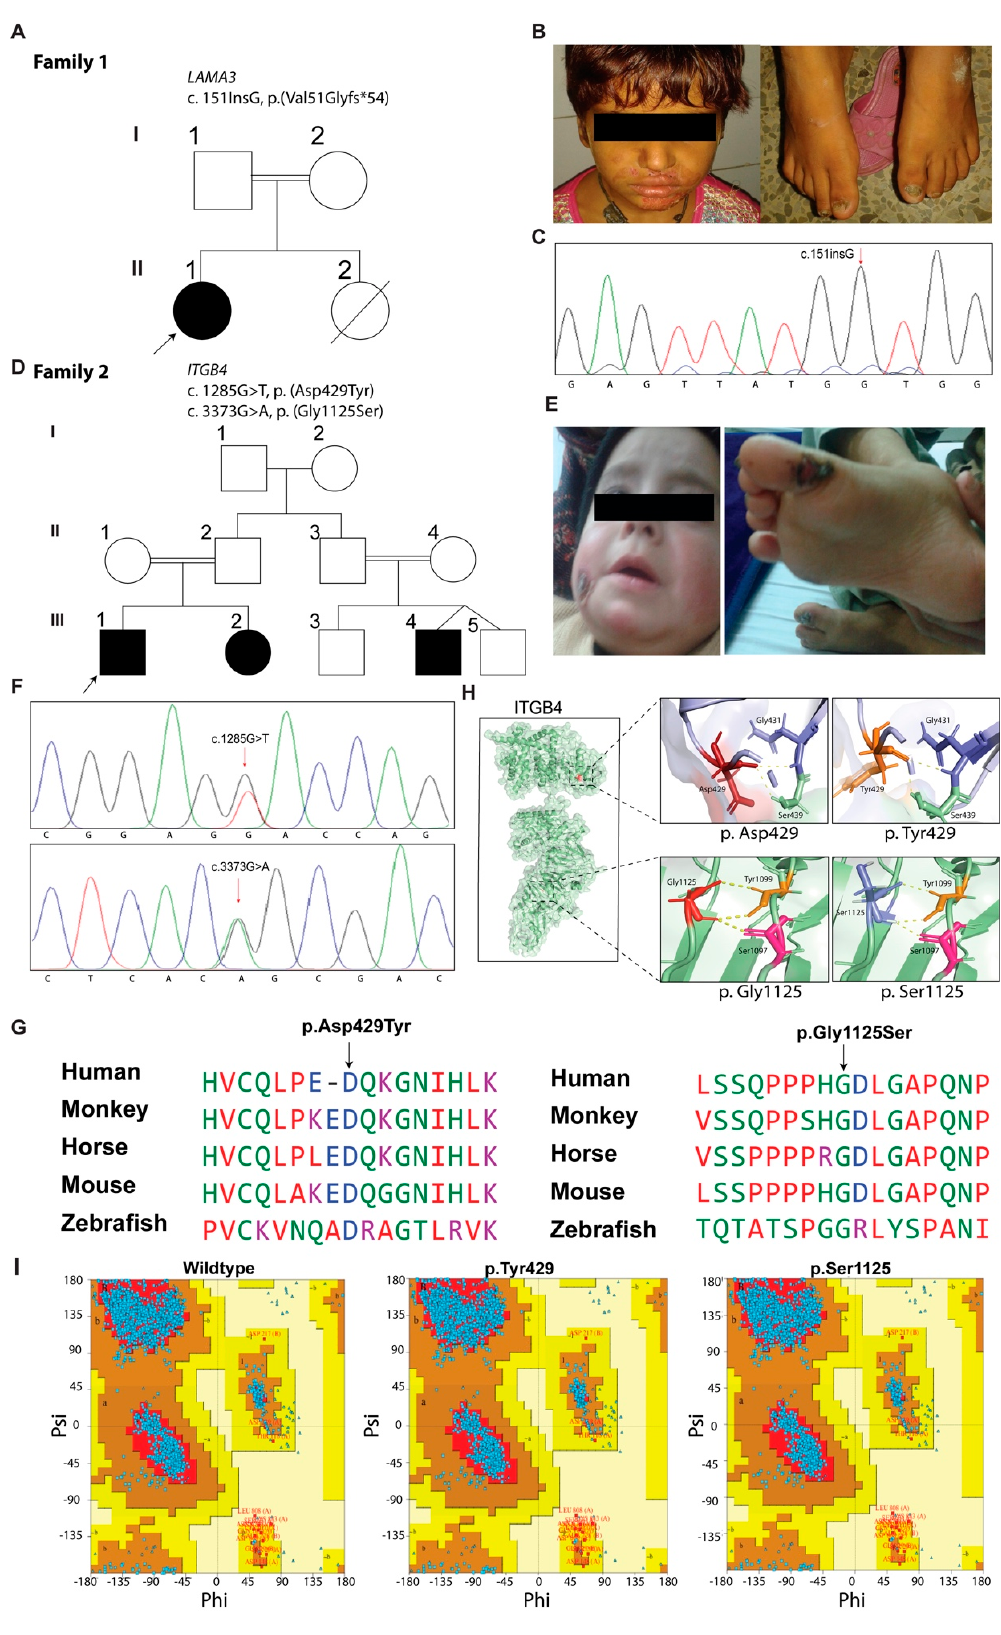
Figure 1. EB phenotypes in families 1 and 2 are associated with pathogenic variants of LAMA3 and ITGB3 , respectively. ( A ) Pedigree of family 1. Filled and empty symbols represent affected and unaffected individuals, respectively. Double lines indicate consanguineous marriages. The arrow points to the proband. A symbol with a line through it indicates a